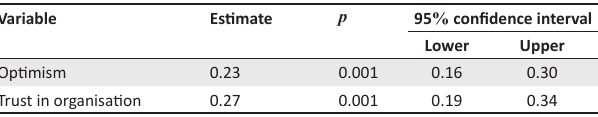
TABLE 4: Indirect effects between authentic leadership and work